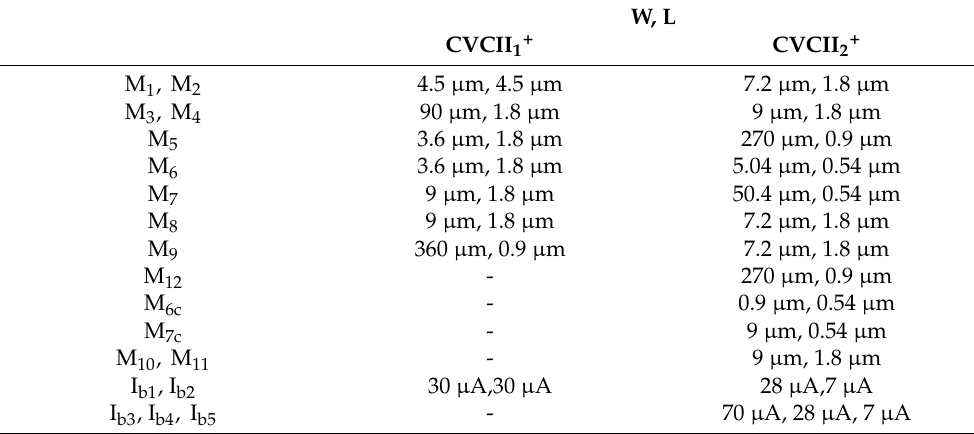
Table 1. CVCII 1+ and CVCII 2+ main transistors aspect ratio and bias